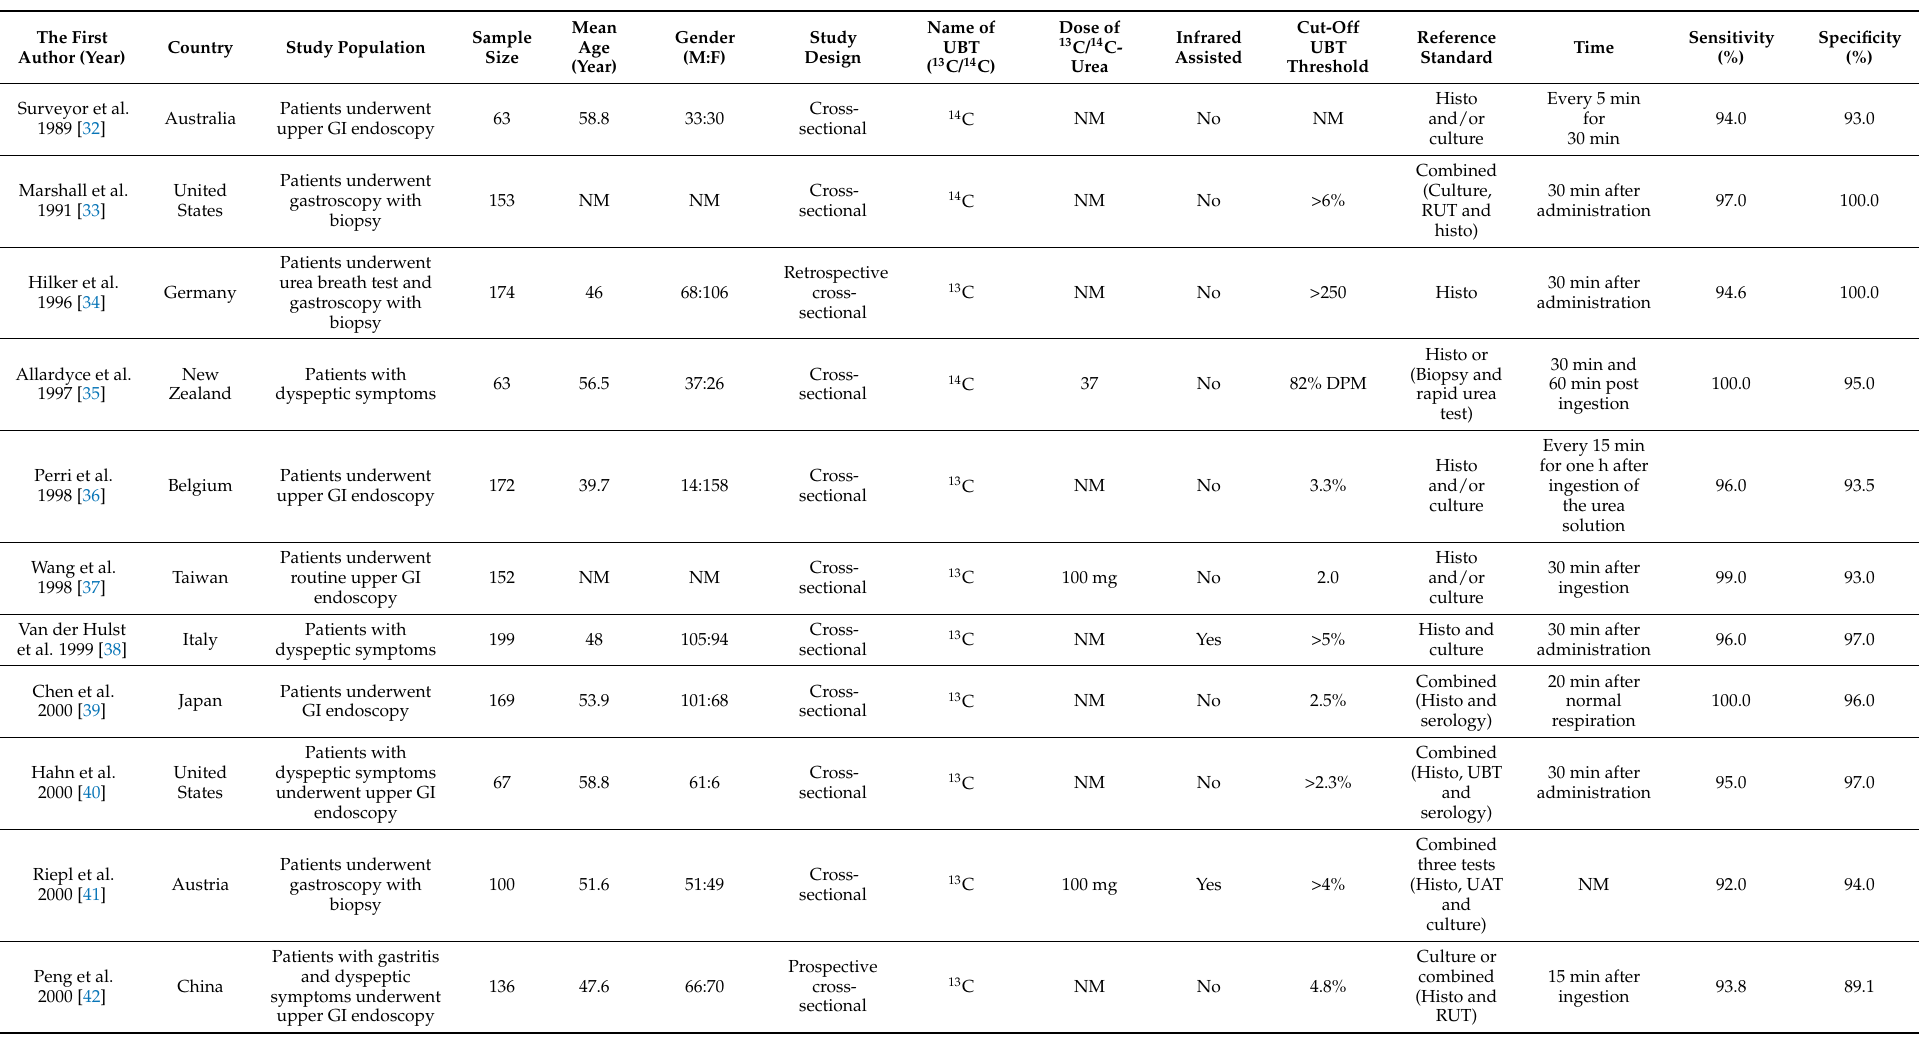
Table 1. The extracted data from the included